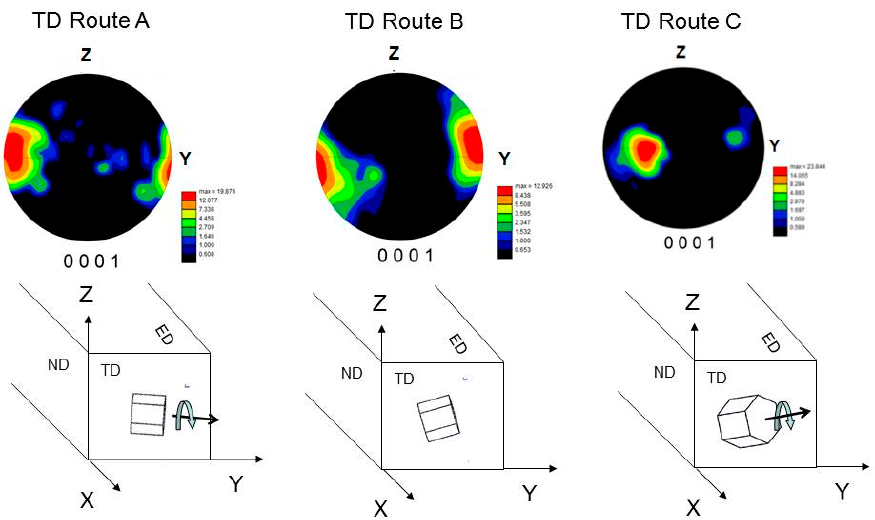
Figure 5. (0001) EBSD pole figures for the TD plane and the corresponding schemes of the prevailing grain